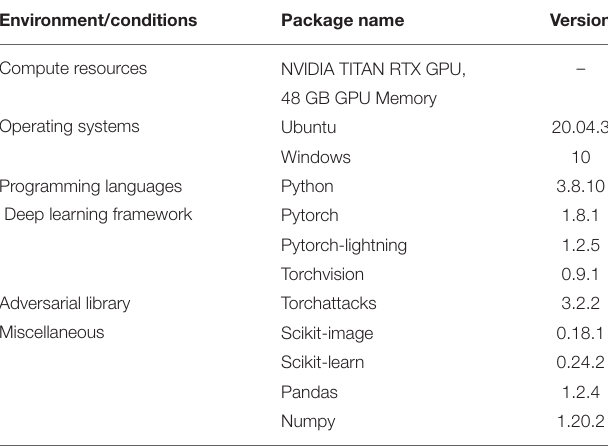
TABLE 1 | Compute resources, frameworks, and packages.